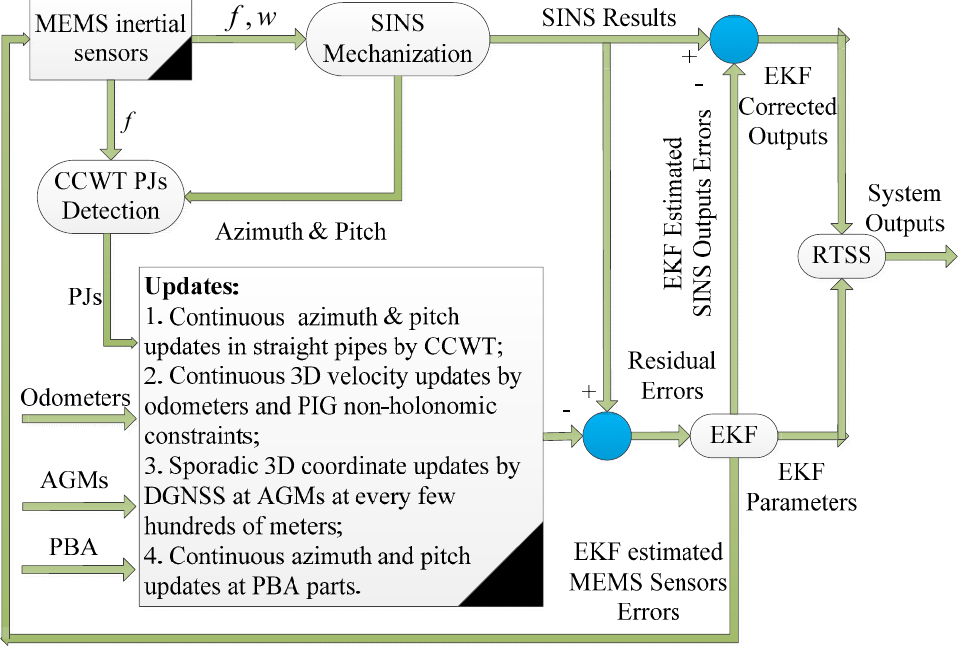
Figure 10. Schematic of SINS/Odo/AGM/PJ/Pipeline Bending Angle (PBA) -based intelligent PIG surveying technology.